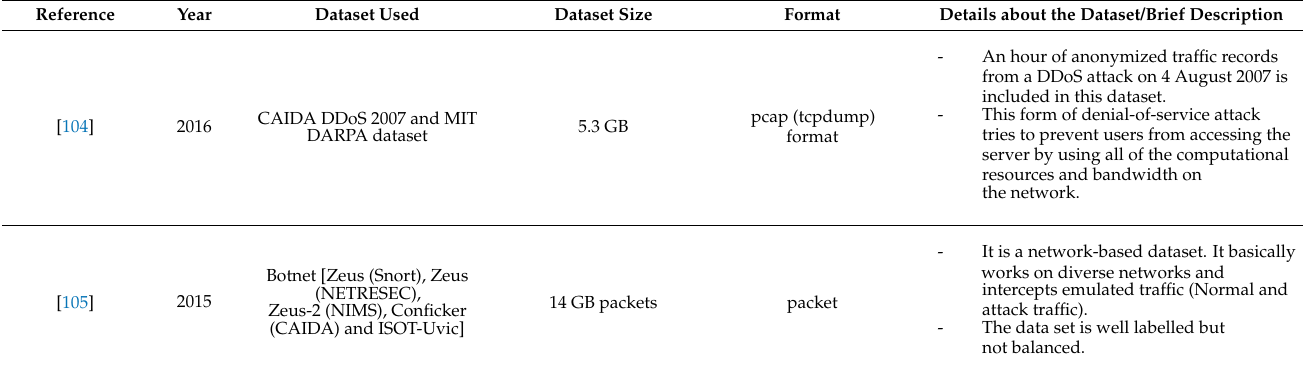
Table 4. List of various cyber-attack